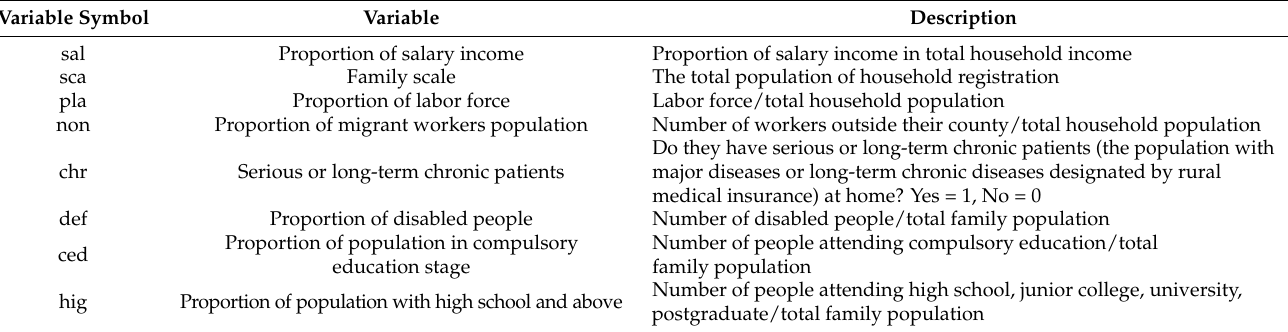
Table 1. Household characteristic variables of resettled farmers